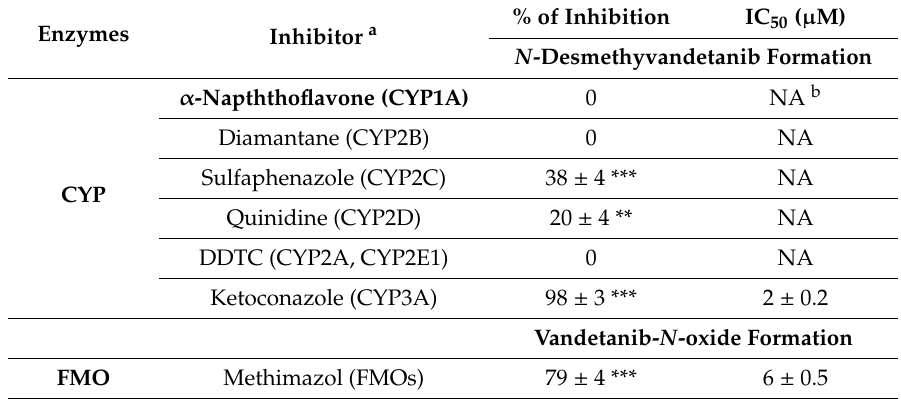
Table 1. E ff ects of CYP and FMO inhibitors on oxidation of vandetanib by human liver microsomes.